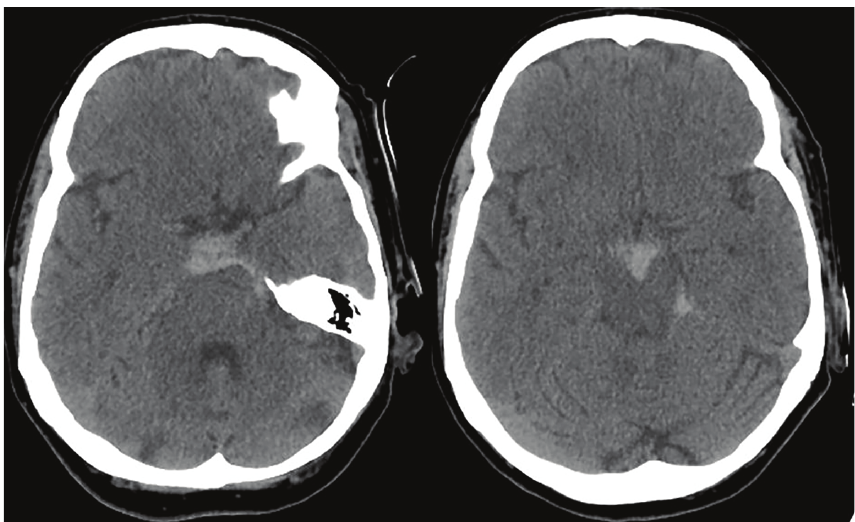
Figure 1: CT of the head demonstrated subarachnoid hemorrhage in the perimesencephalic, prepontine, interpeduncular cisterns.